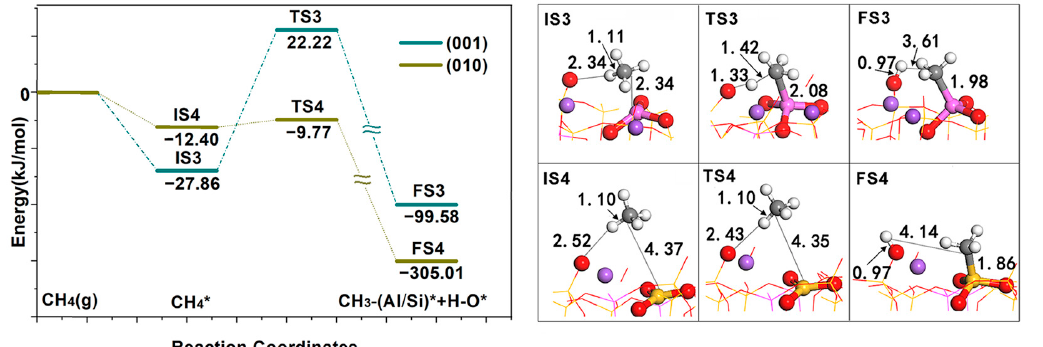
Figure 5. Geometric structures of the transition state intermediates of the activation reactions of CH 4 on the FLP of NaAlSi 3 O 8 (010) and (001) surfaces. * indicates adsorption state, (g) indicates in gas phase state.